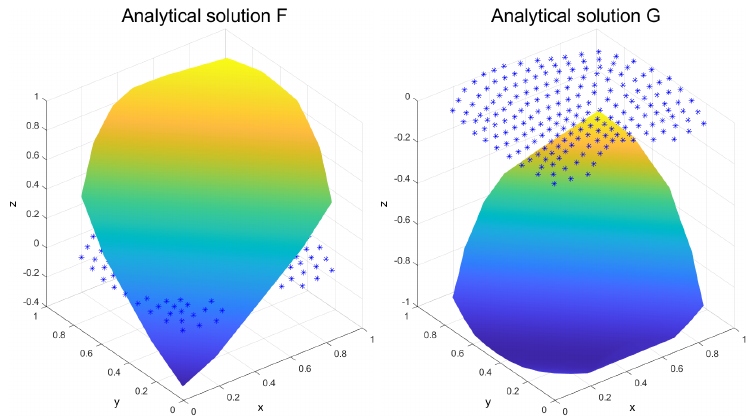
Figure 2. Analytical solutions of